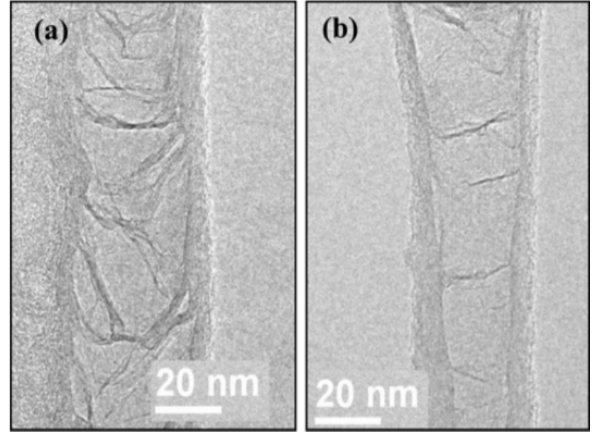
Figure 16. ( a ) TEM images of BCNTs with complete knots. ( b ) TEM images of BNCTs with incomplete knots [62].